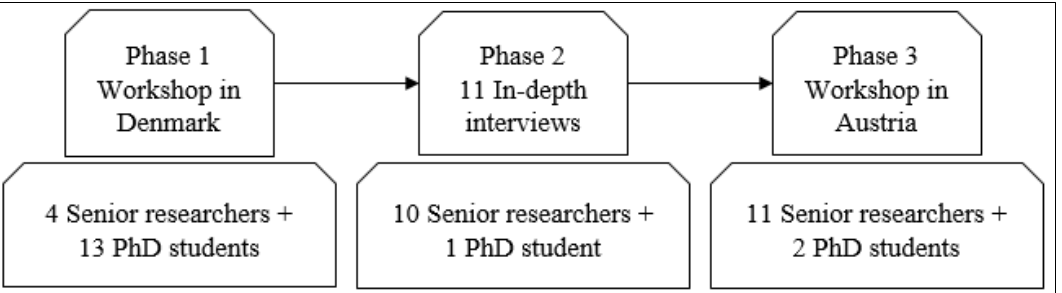
Figure 3. Three phases of data collection. Source: own illustration.